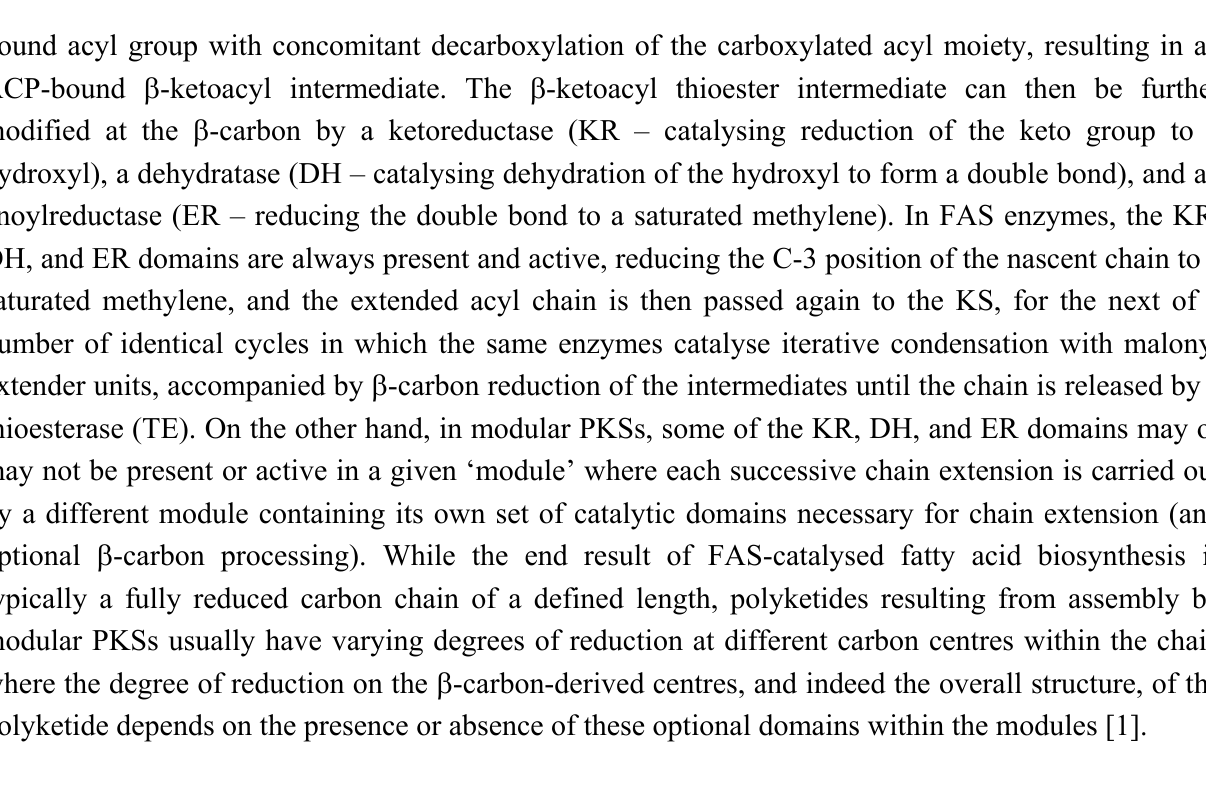
Figure 2. Biosynthesis of fatty acids (solid arrows) and polyketides (solid/dashed